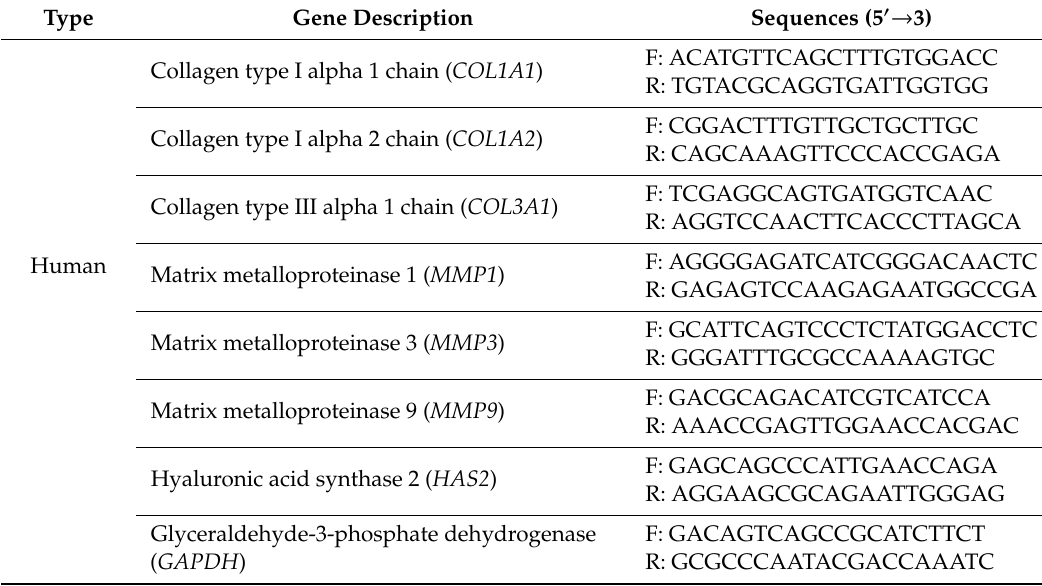
Table 1. The primer sequences.